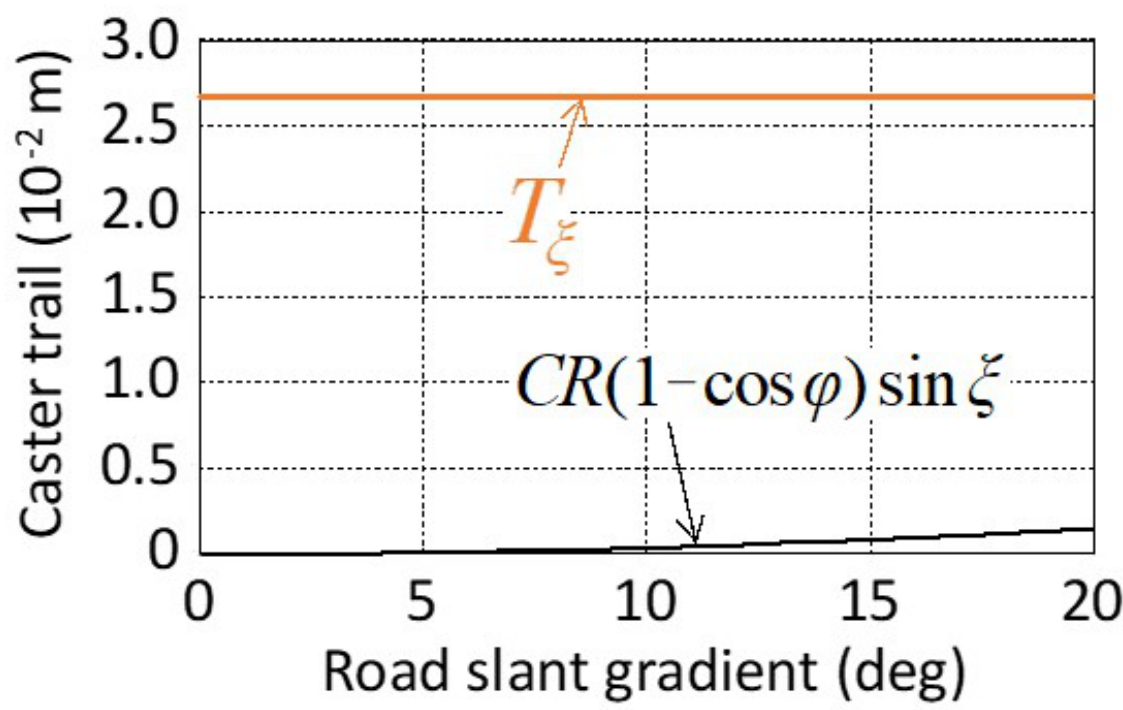
Figure 19. Reduced caster trail on a slanted